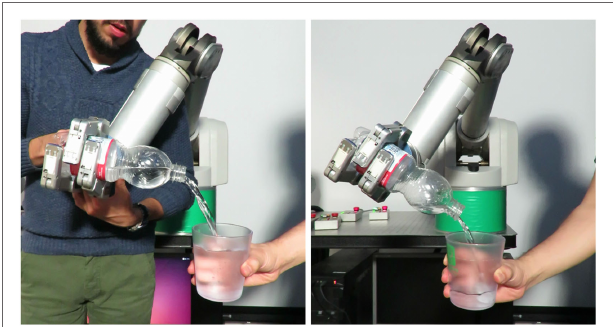
FIGURE 1 | Experimental setting of the pouring task . Kinesthetic teaching and reproduction are shown in the left and right pictures, respectively. The amount of fluid inside the bottle is sensed by a force-torque sensor attached to the wrist of the